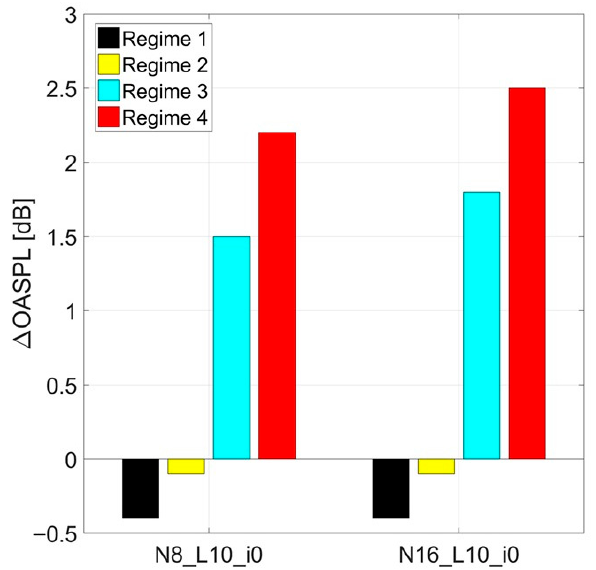
Figure 6. Noise reduction of the chevron nozzles for all the tested regimes.